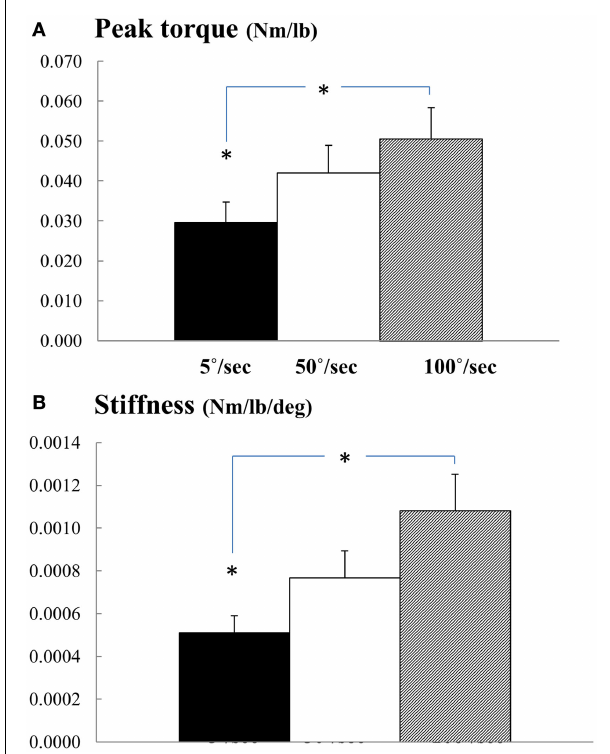
FIGURE 3 | (A) Normalized peak torque and (B) stiffness at three speeds. Mean and SEs are plotted. * represents statistical significance.